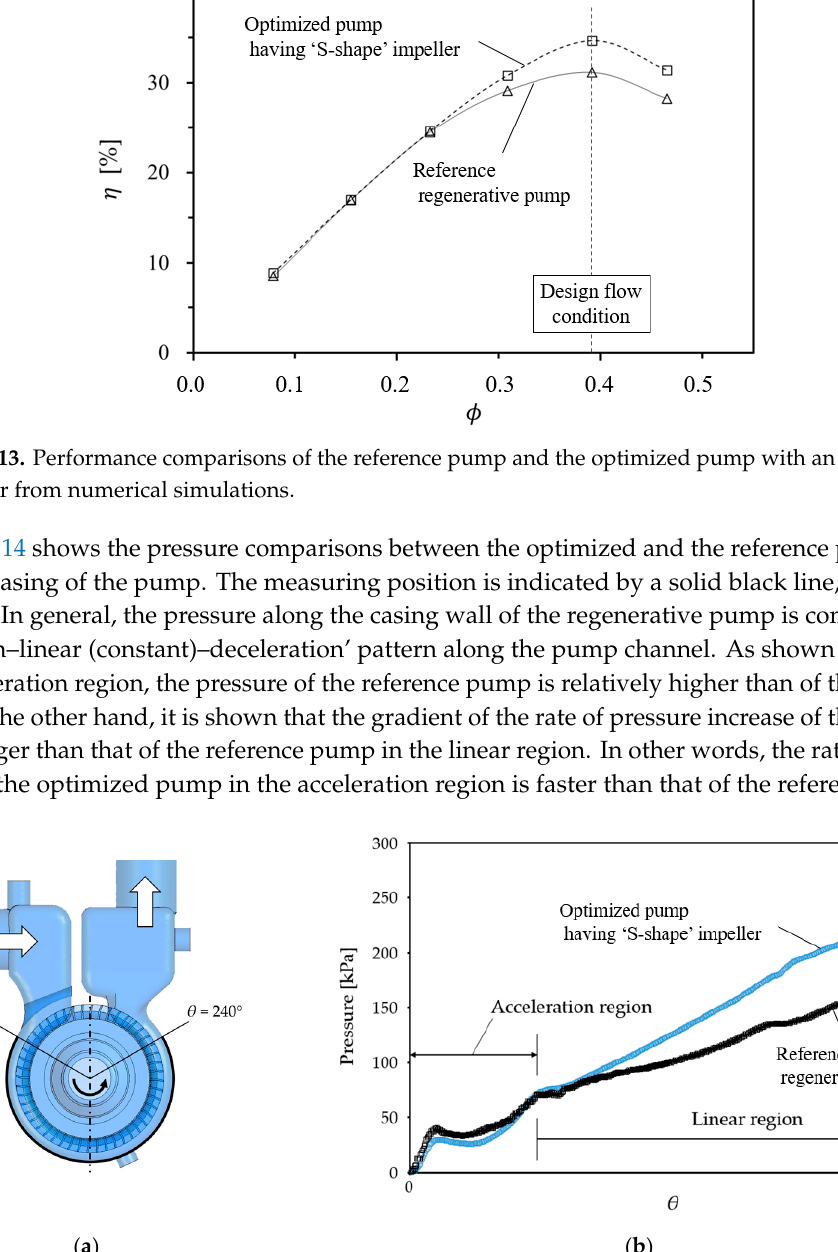
Figure 12. Optimal design of ‘S-shape’ impeller: ( a ) solid modeling; ( b ) manufactured impeller.